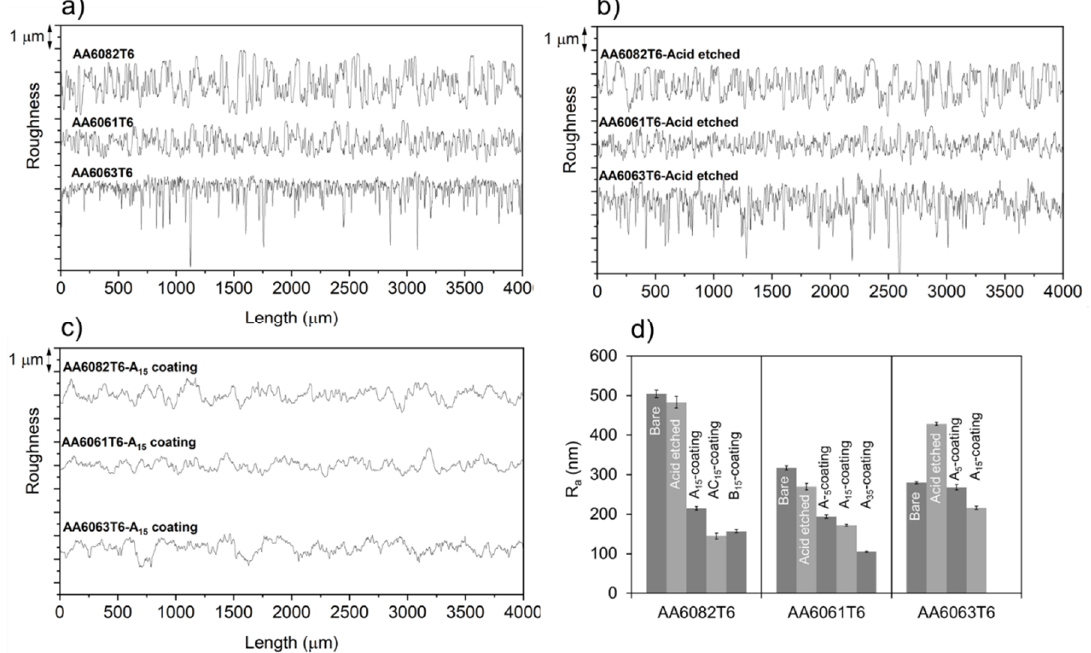
Figure 4. Surface profile of ( a ) raw, ( b ) acid etched, ( c ) A-coated at 15 cm / min AlMgSi alloys and ( d ) average roughness R a .